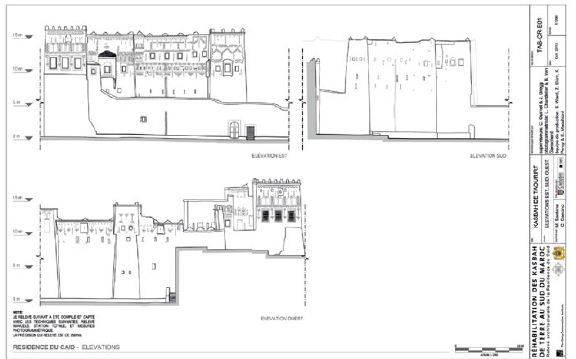
Figure 6: Elevations of the Caïd Residence within the Kasbah Taourirt , created from photogrammetric models.